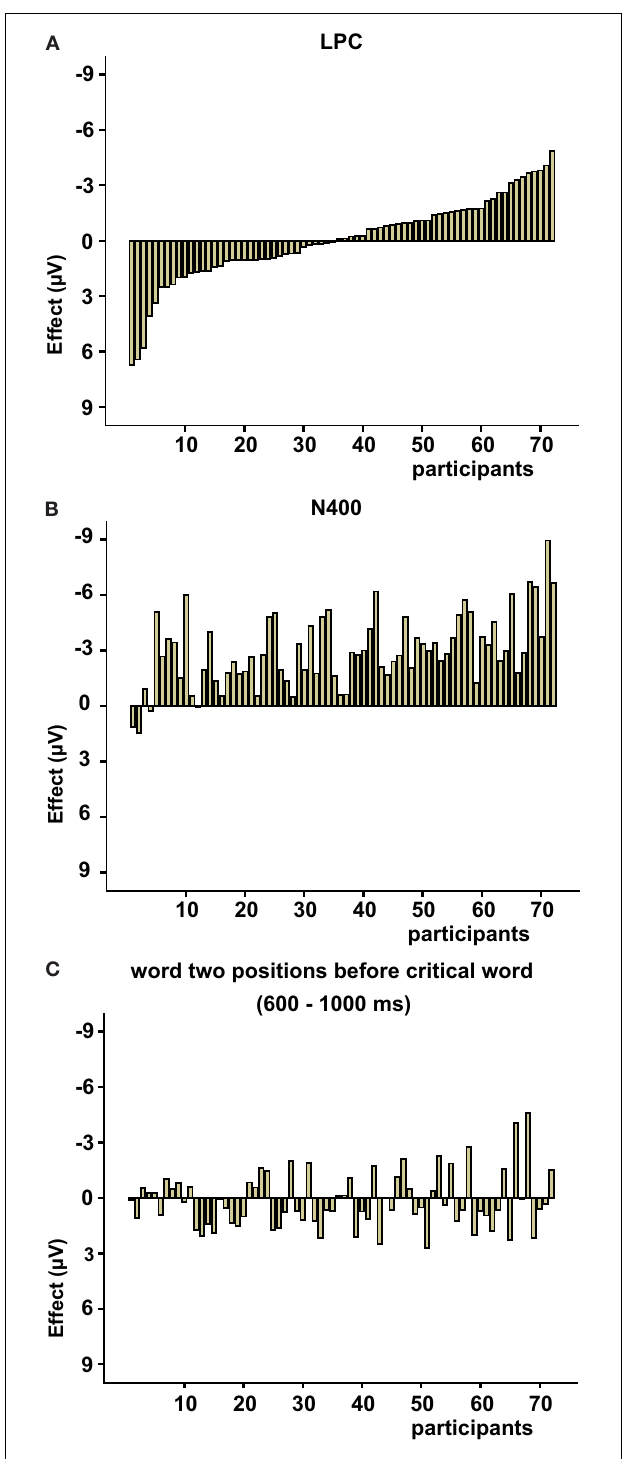
FIGURE 4 | (A) Scatter plot of the effect of the semantic manipulation within the LPC time window (600–1000ms) and the P600 effect elicited by subject-verb agreement violations within the same latency window, which are correlated. (B) Scatter plot for half of the participants who were offered two semantic manipulations.The plot shows the effects within the LPC time window.These effects are highly